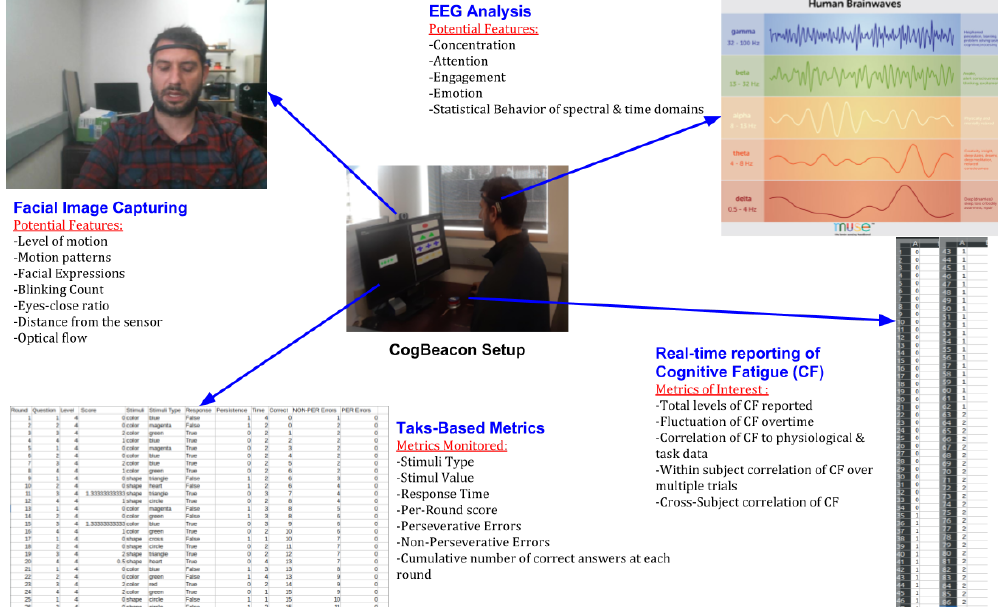
Figure 11. An overall visualization of the CogBeacon data-collection framework. It must be noted that for the purposes of this study we just considered the raw features as described in Section